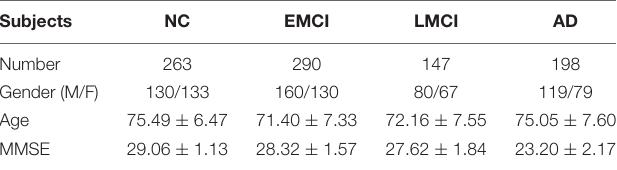
TABLE 1 | Demographic characteristics of the subjects in the ADNI